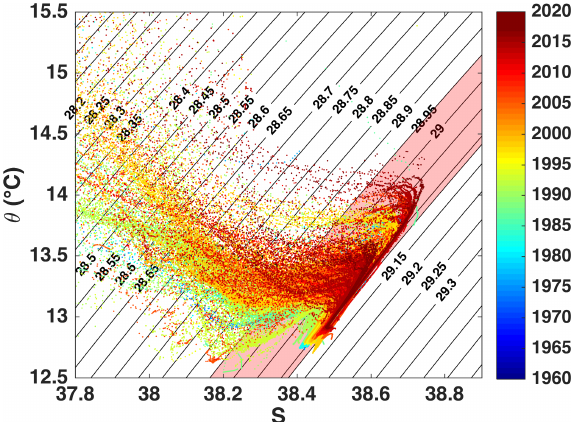
Figure 2. θ – S diagram of CTD casts performed within the polygons shown in Fig. 1, color-coded according to their dates. The black contours show isopycnals. The red shaded area (between 28.95– 29.115kgm − 3 ) is the zone considered to determine LIW character-